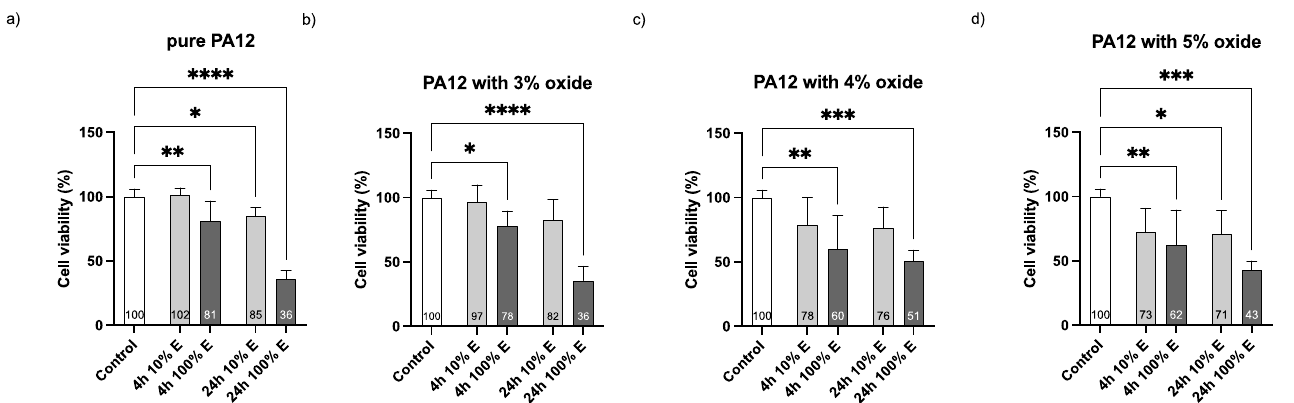
Figure 9. Cell viability: MTT assay. Histograms represent the percentage, with respect to control cells (Ctrl, 100%) of viable cells after 24 h treatment with 4 h and 24 h extracts at 10 and 100% concentration from ( a ) pure PA12; ( b ) PA12 with 3 wt % of metal oxides; ( c ) PA12 with 4 wt % of metal oxides; ( d ) PA12 with 5 wt % of metal oxides. Differences with p < 0.05 were considered statistically significant. One asterisk (*) indicates p < 0.05, two asterisks (**) indicate p < 0.01, three asterisks (***) indicate p < 0.001, four asterisks (****) indicate p < 0.0001.